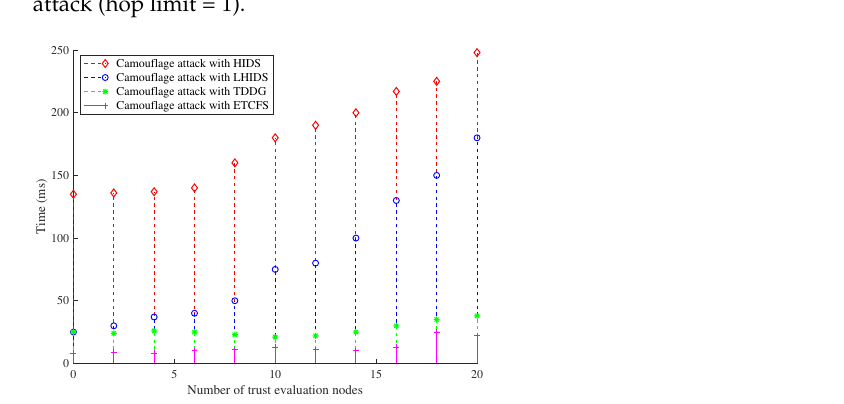
Figure 6. The time consumption with cluster formulation under different schemes in camouflage attack (hop limit =